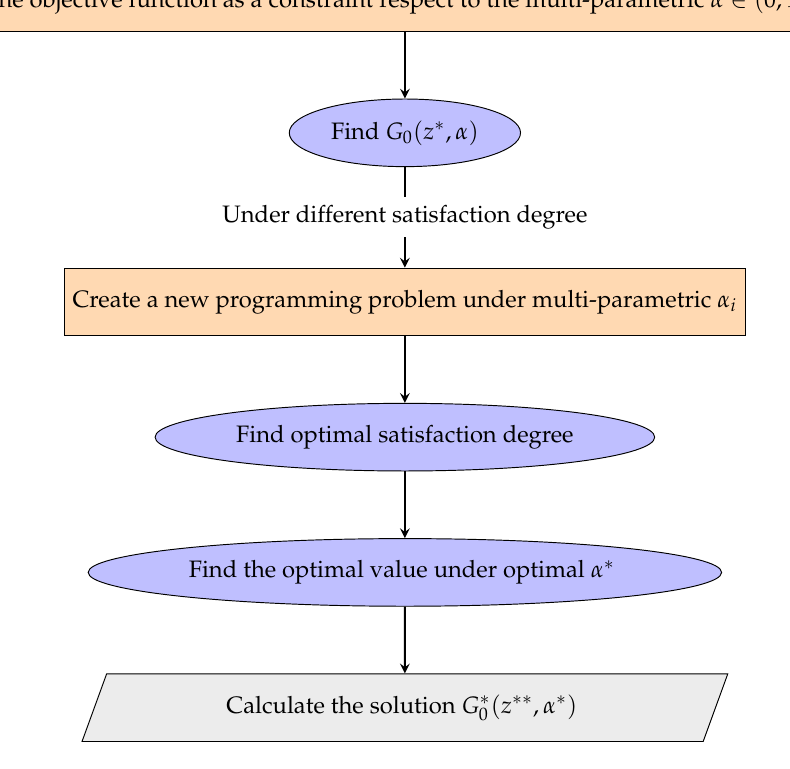
Figure 1. A flowchart for our method